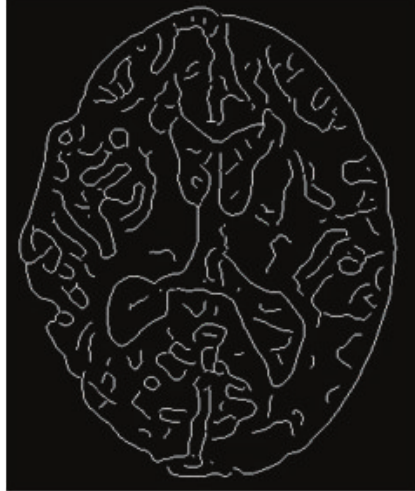
Figure 4: Edge of brain tissue